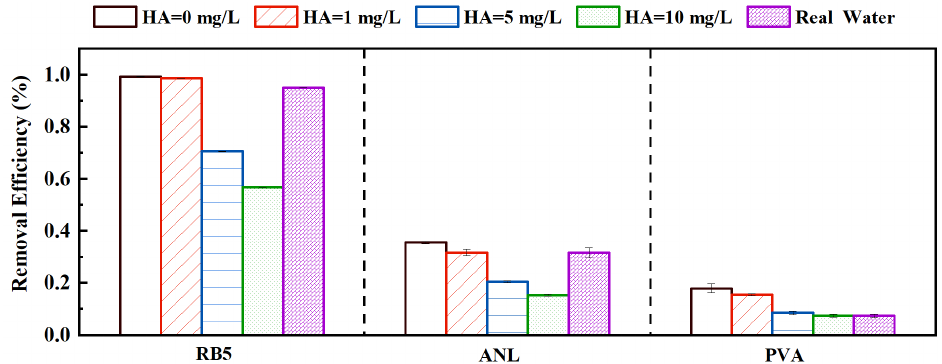
Figure 4. Effect of coexisting HA and real water matrix on the degradation of RB5, PVA and ANL in Fe 2+ /PAA/H 2 O 2 system. Conditions: [PAA] = 15 mg/L, [RB5] 0 = 20 mg/L, [PVA] 0 or [ANL] 0 = 10 mg/L, pH = 3.0, T = 21 ± 1 °C.